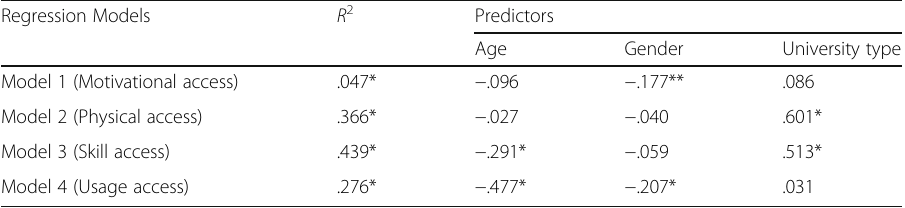
Table 3 Summary of regression results predicting the four levels of ICT access Regression